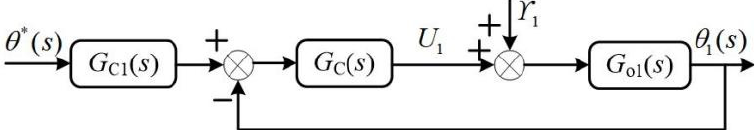
Figure 6. Block diagram of equivalent transfer function.